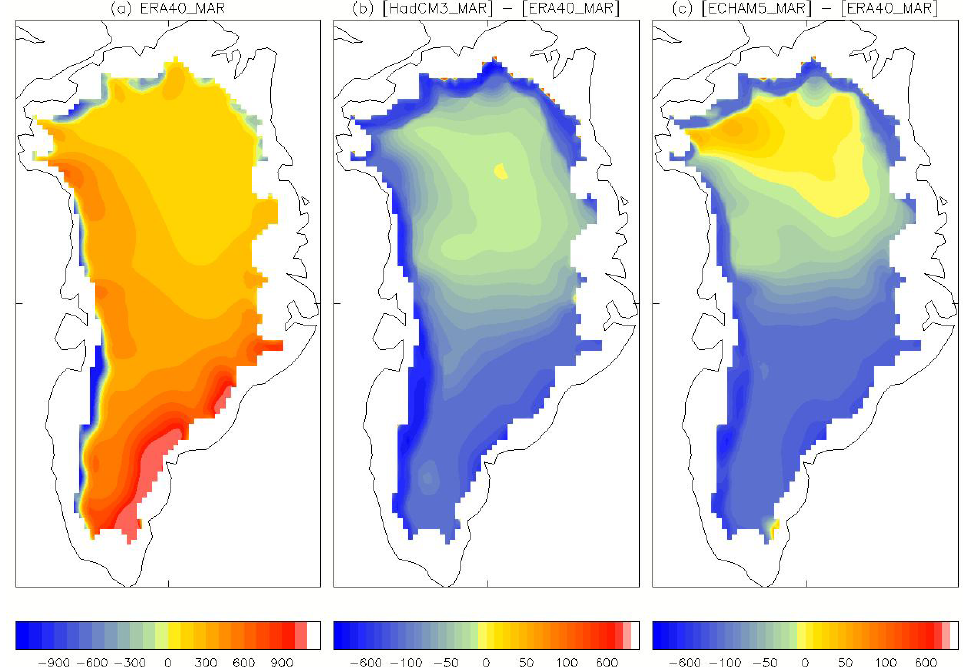
Fig. 8. 1980–1999 mean surface mass balance (SMB), in mmw.e.yr − 1 . (a) ERA40-forced MAR. (b) Difference between HadCM3-forced MAR and ERA40-forced MAR. (c) Difference between ECHAM5-forced MAR and ERA40-forced MAR.